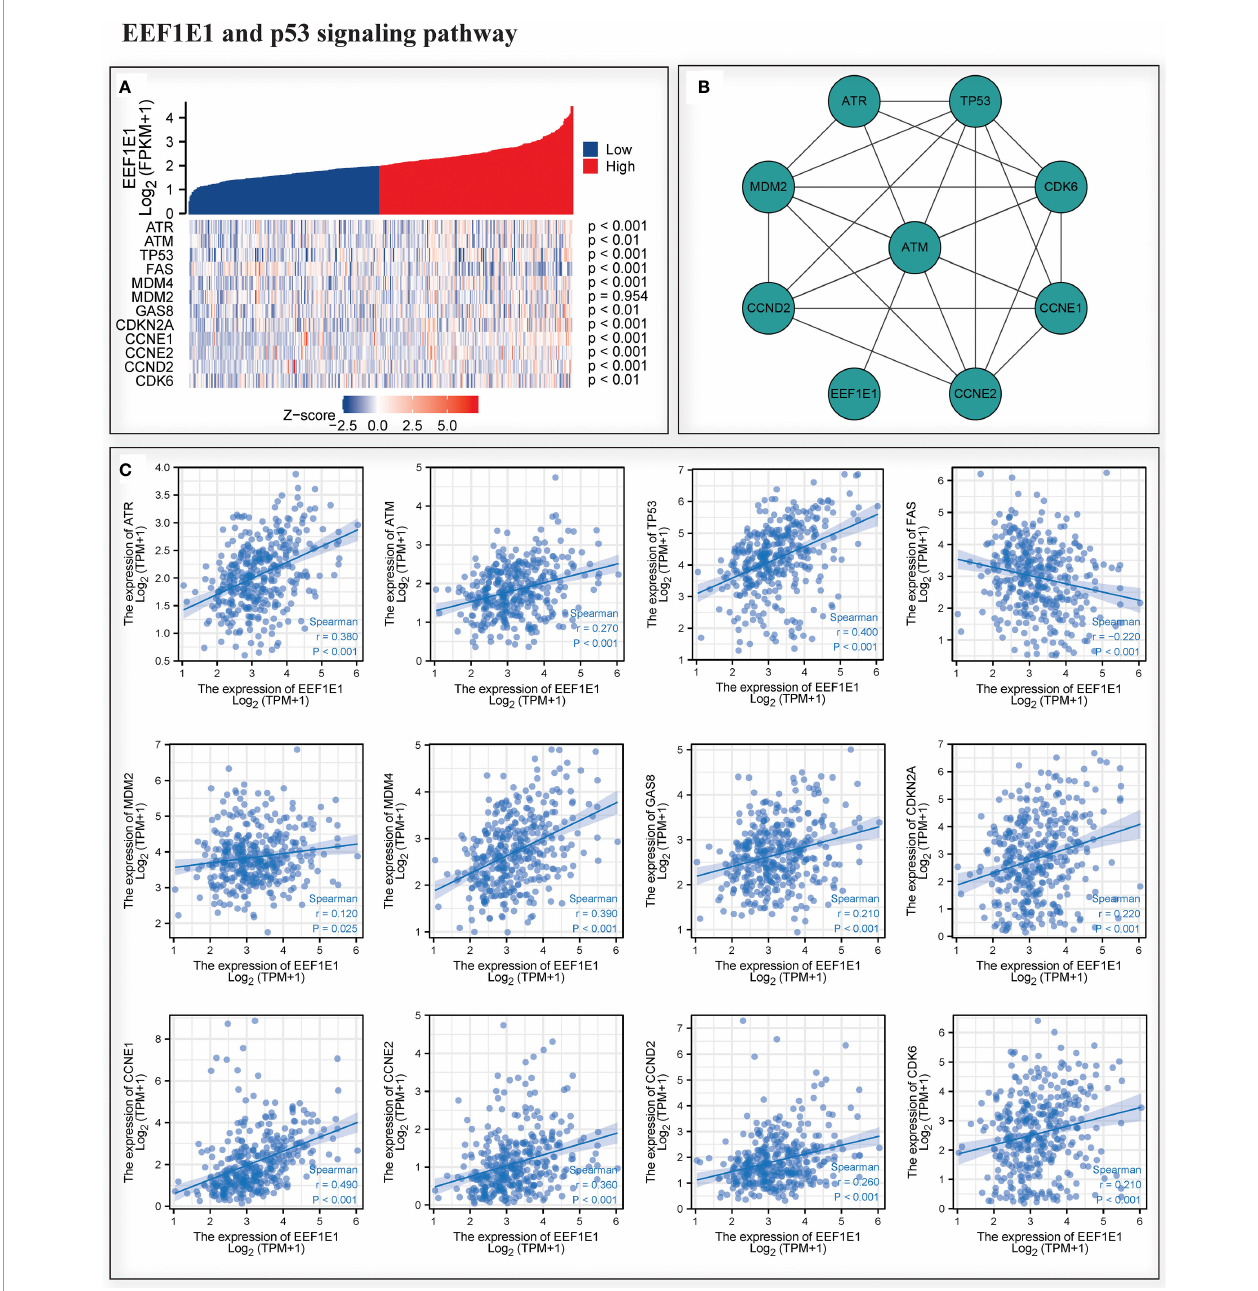
FIGURE 8 | Correlation between the expression of EEF1E1 and p53 pathway. (A) Correlation between the expression of EEF1E1 and p53 pathway key molecules expression level. (B) Network map showing the interaction of EEF1E1 and p53 pathway key molecules. (C) Correlation between the expression of EEF1E1 and p53 pathway key molecules expression